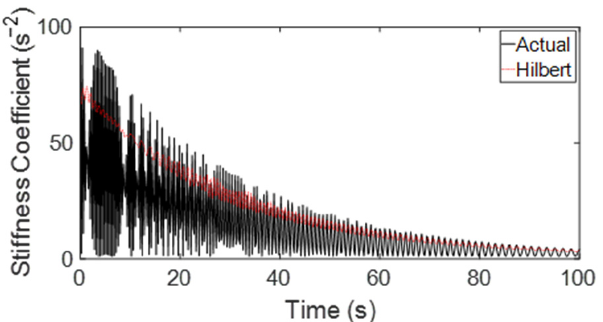
Figure 8. Instantaneous system stiffness coefficient by Hilbert transform.